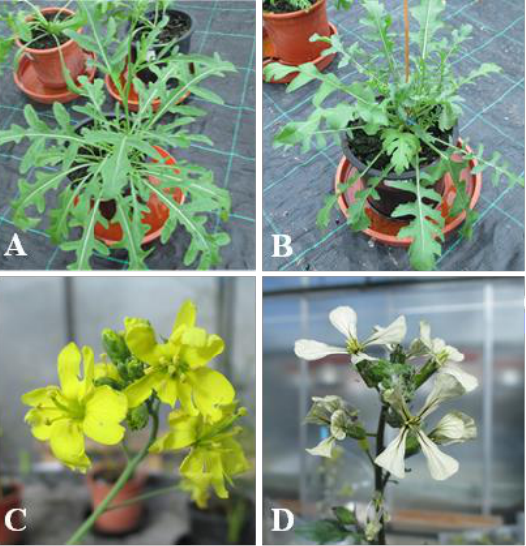
Figure 1. ( A ) Diplotaxis tenuifolia ; ( B ) Eruca sativa ; ( C and D ) Respective inflorescences.